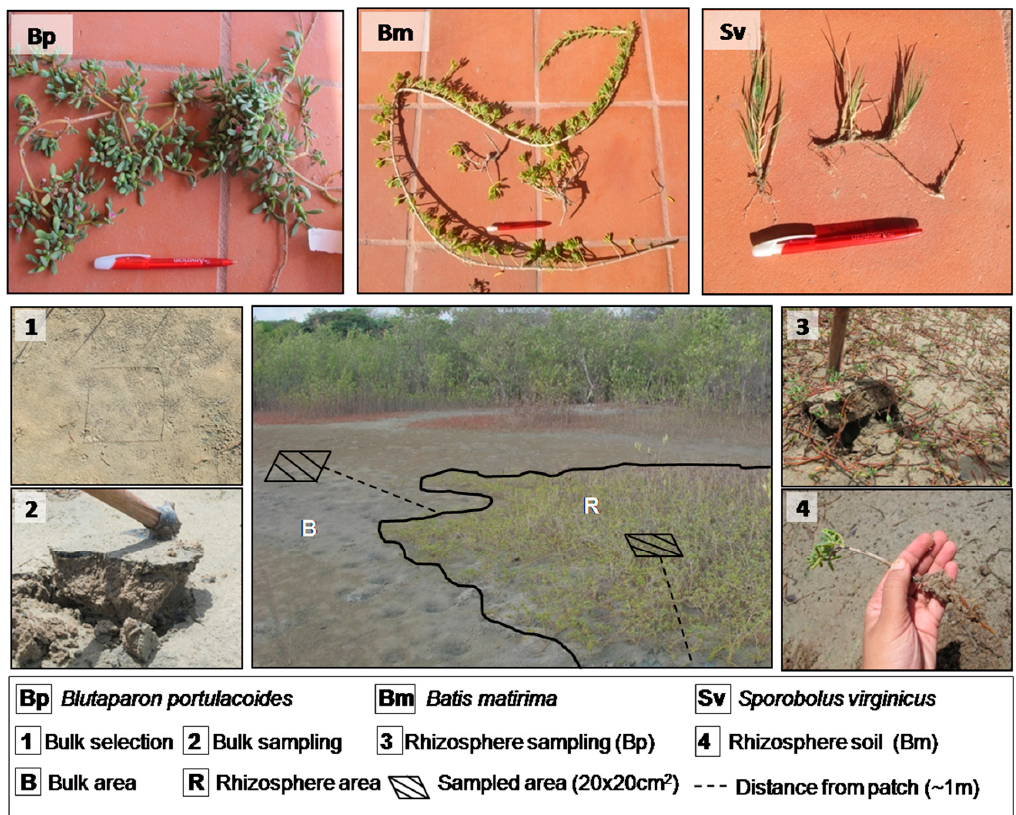
Figure 2. Studied plant species and soil sampling in the hypersaline tidal flat (HTF) of the Pacoti estuary.